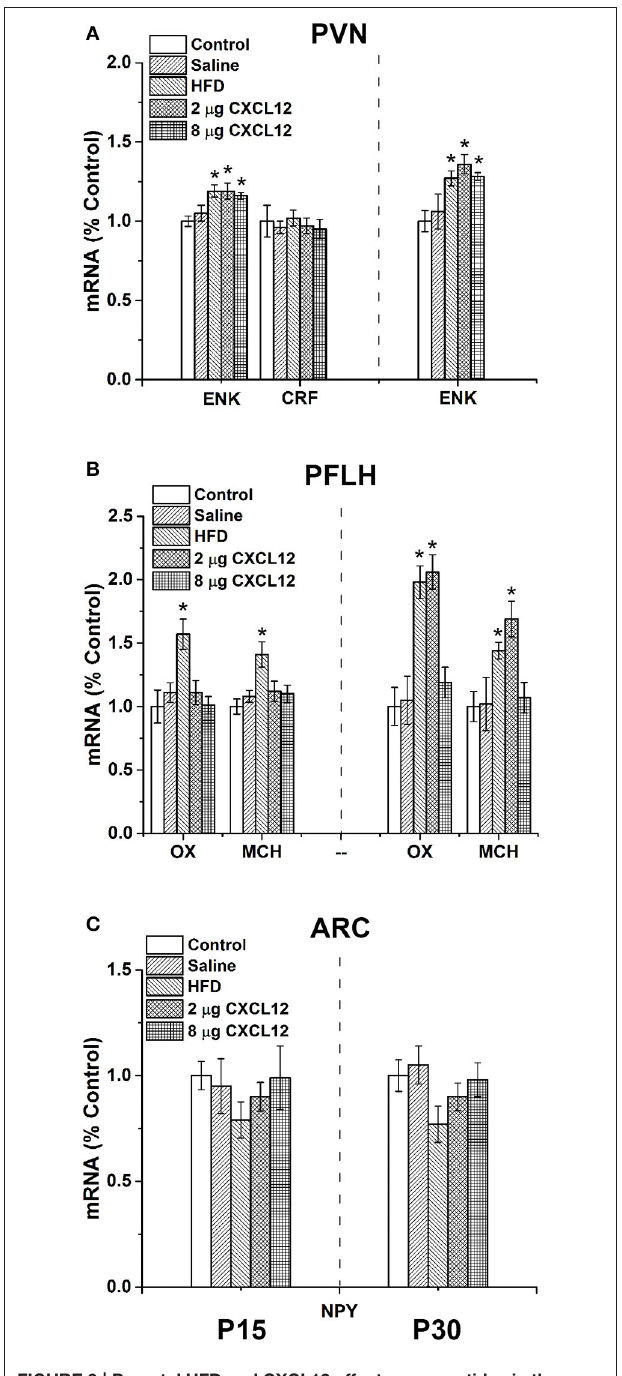
FIGURE 3 | Prenatal HFD and CXCL12 affect neuropeptides in the hypothalamus of offspring. The graphs represent the expression of neuropeptides at postnatal day 15 (P15) (left) and P30 (right). (A) In the PVN, a significant increase of enkephalin (ENK) was found with both prenatal HFD exposure and CXCL12 at 2 and 8 µ g at P15 and P30, with no effect of saline as compared to control. No effect was seen on corticotrophin-releasing factor (CRF) at P15. (B) In the PFLH, a significant increase in orexin (OX) and melanin-concentrating hormone (MCH) was found with prenatal HFD exposure at P15 and P30, but there was no effect of prenatal exposure to CXCL12 at 8 (Continued)